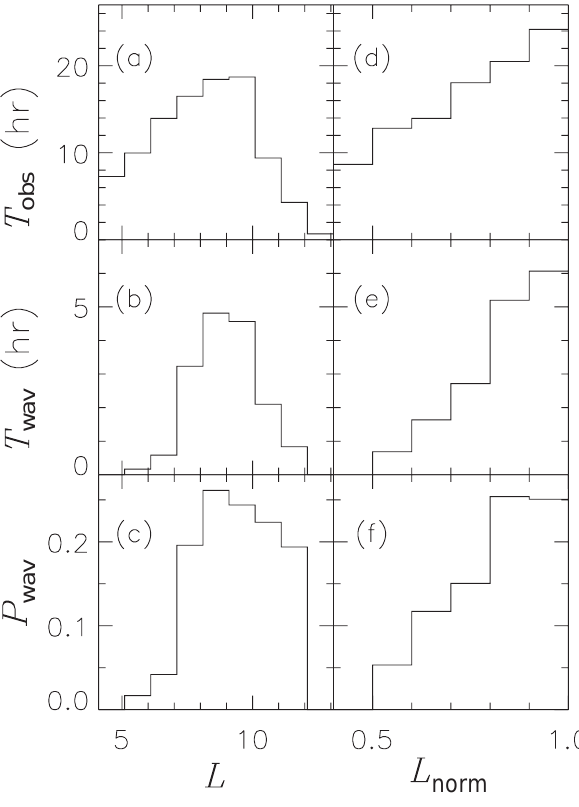
Fig. 2. (a) Total time of observations T obs in hours, (b) total time of Pc 1 wave activity T wav in hours, and (c) Pc 1 wave occur- rence probability P wav = T wav /T obs in L bins 3.1–4.1, 4.1–5.1, ... , 12.1–13.1. Panels (d), (e), and (f) show the same quantities as were plotted in (a), (b), and (c), respectively, but now plotted versus L norm ≡ L/L mp for L norm bins 0.4–0.5, 0.5–0.6, ... ,